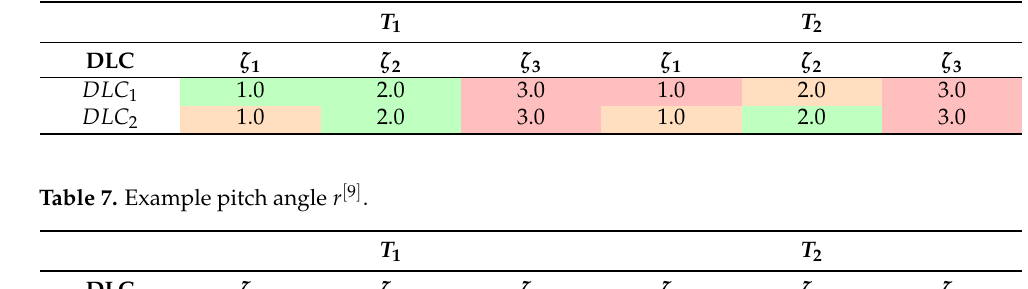
Table 6. Example RNA vertical acceleration r [ 8 ] .